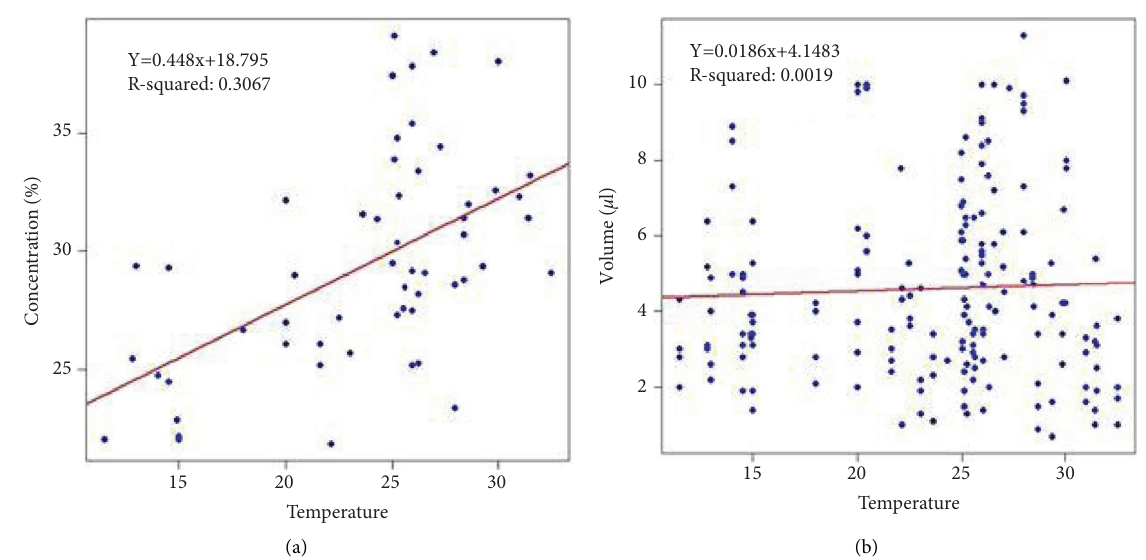
Figure 7: Efects of temperature on nectar concentration (a) and volume (b) of S. leucantha